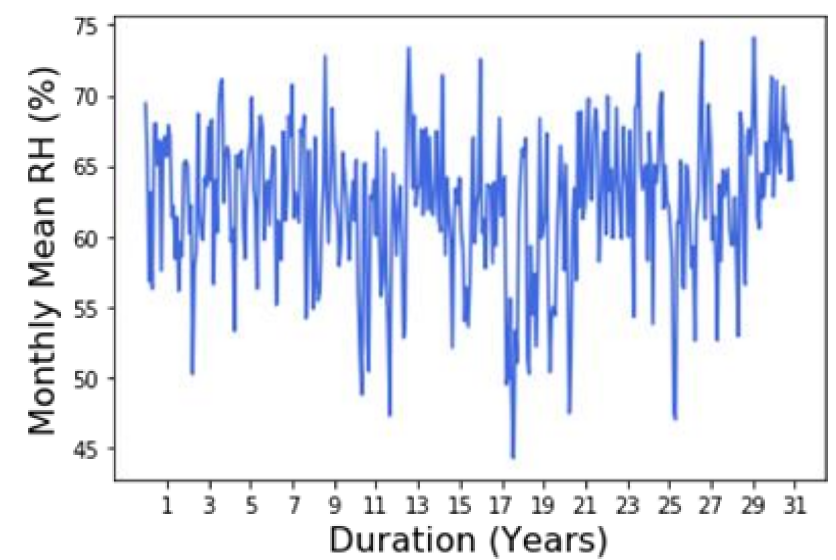
Figure 9. Outdoor relative humidity profile for run 10 in historical climate data of the city of Calgary.